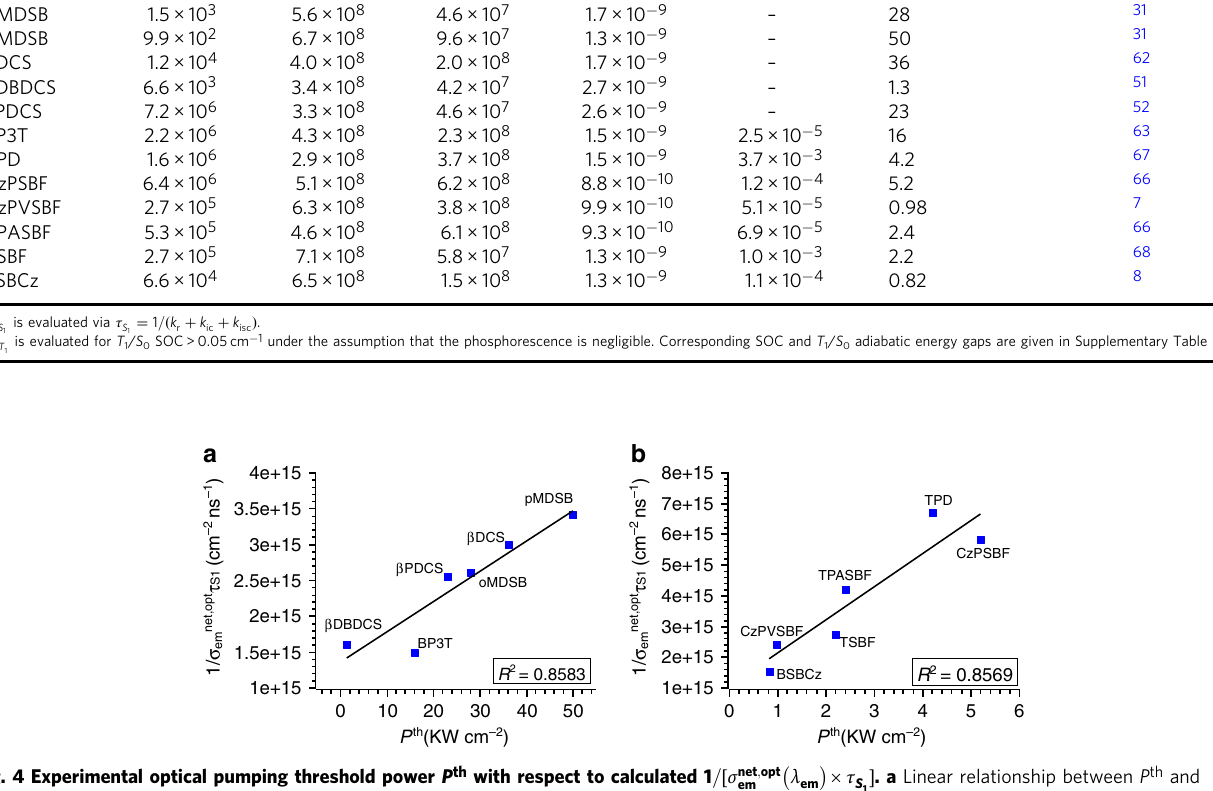
Table 4 Theoretical photophysical properties and experimental threshold power for 12 candidates. Molecule